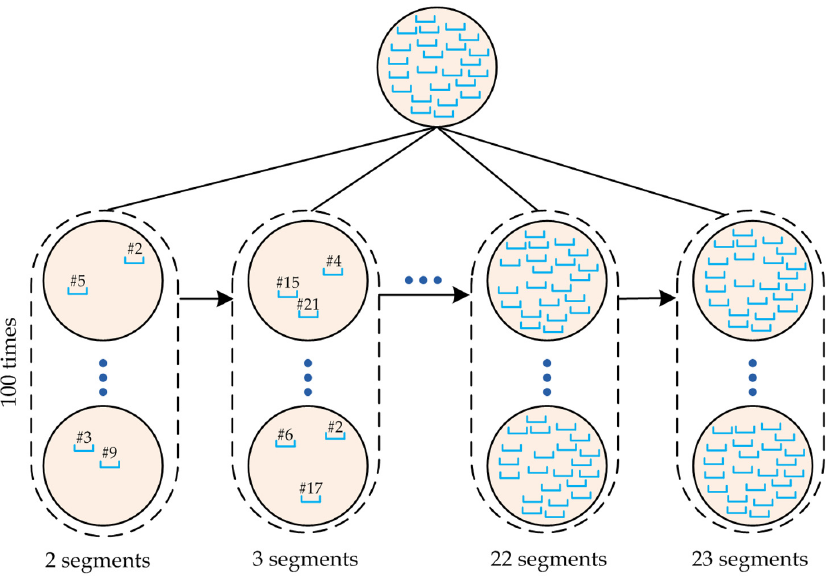
Figure 6. Random rules for selecting different numbers of time segments.